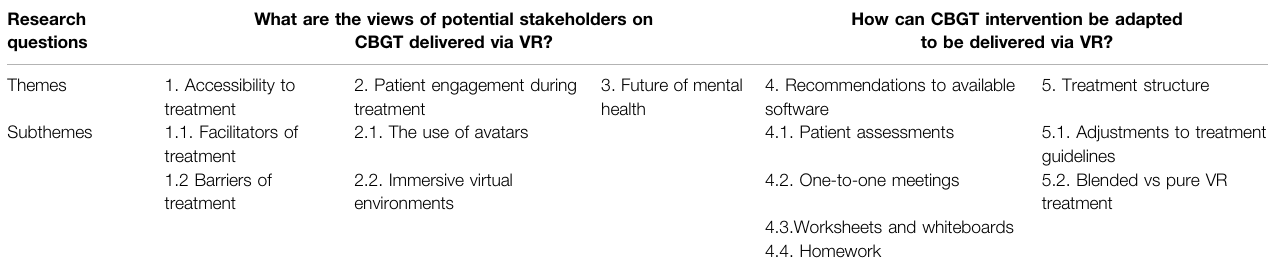
TABLE 3 | Themes and